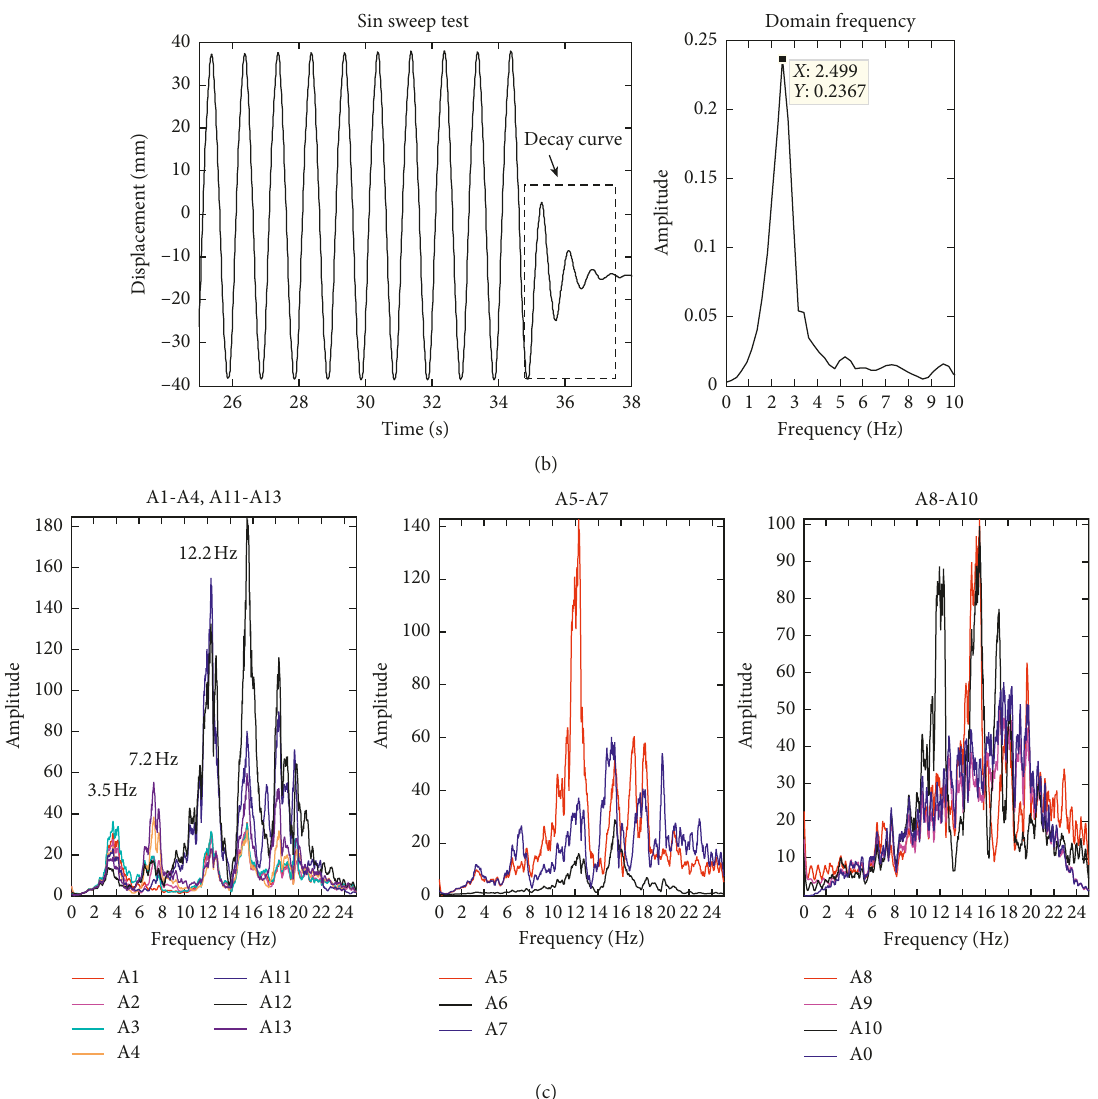
Figure 10: The lateral natural frequencies of test structure. (a) Human traction test results. (b) Sin sweep test results. (c) White-noise test